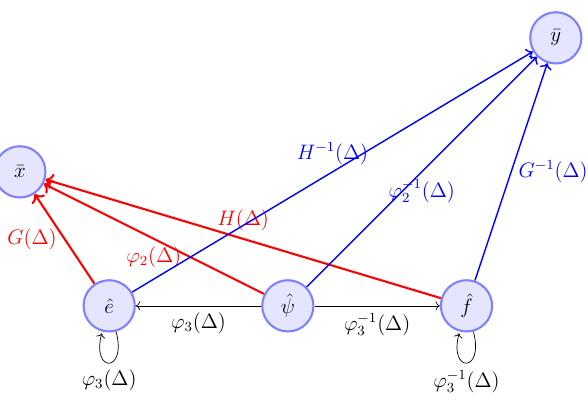
Figure 3 . The OPE relations involving (cid:22) x and (cid:22) y